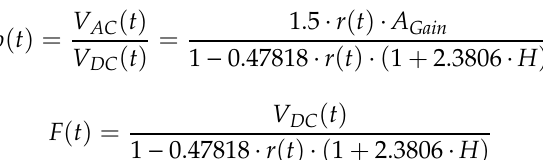
Figure 3. Circuit diagram for the dual-channel SF filtering box. The frequency selection circuitry filtered out the r(t) , and F(t) traces by getting the ratio of V AC (t) / V DC (t) , according to Equation (7) and Equation (8), respectively. The fluorescence emission that passes the interference filter (e.g., 520 nm, 580 nm, and 620 nm) produces a PMT analog signal (signal in) that is split into two, the first half goes through an adjustable resister-capacitor filter ( RC ) to obtain a clean V DC (t) signal out. This RC filter has a variable capacitor set for the following time constants of 1 ms, 10 ms, 50 ms, 100 ms, and 500 ms